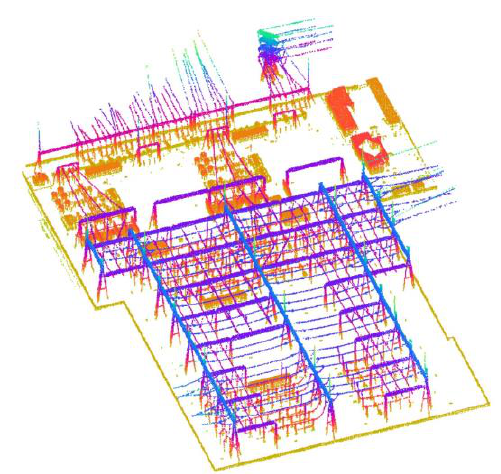
Figure 6. Extraction of the equipment point clouds after dimension feature estimation and region growth. The main body of substation point clouds are maintained, which is a foundational process for substation